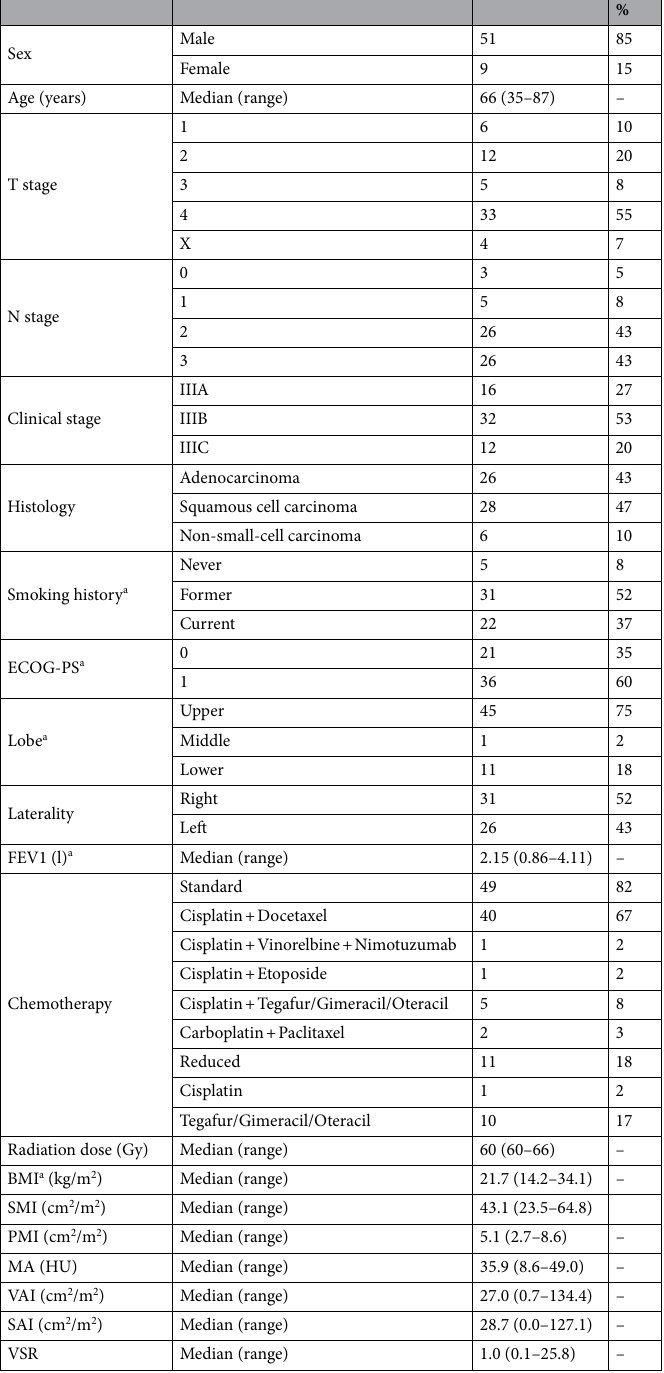
Table 1. Patient characteristics. ECOG-PS Eastern Cooperative Oncology Group performance status, FEV1 forced expiratory volume in 1 s, BMI body mass index, MA mean muscle attenuation, SMI skeletal